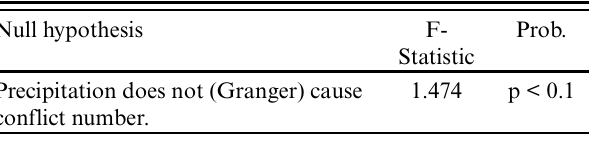
Prob. Statistic 1.474 p <